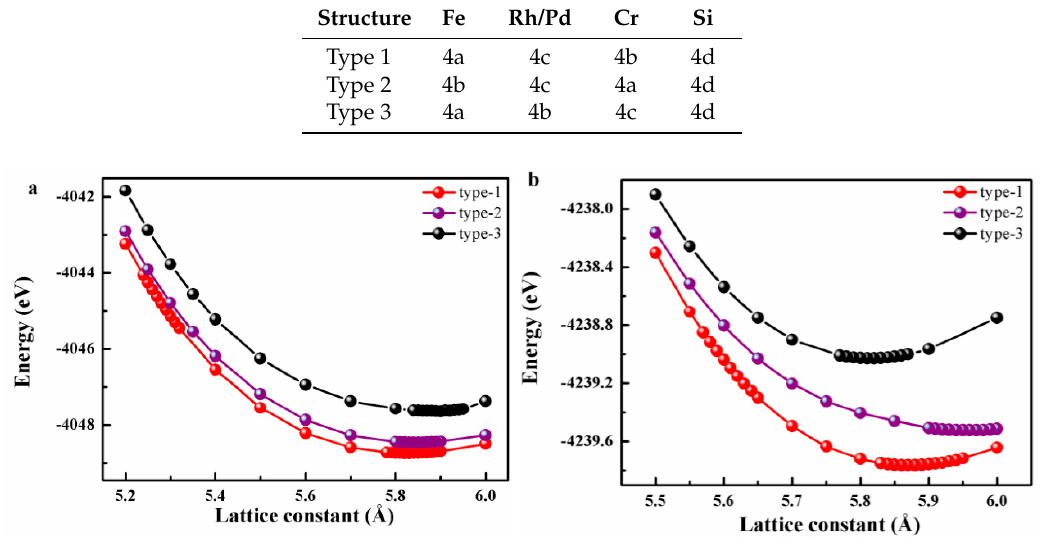
Figure 1. The three possible structures of FeRhCrSi and FePdCrSi ( a ) type-1, ( b ) type-2 and ( c ) type-3. Figure1. The three possible structures of FeRhCrSi and FePdCrSi (a) type-1, (b) type-2 and (c) type-3. Table 1. Three possible structures of FeRhCrSi and FePdCrSi.